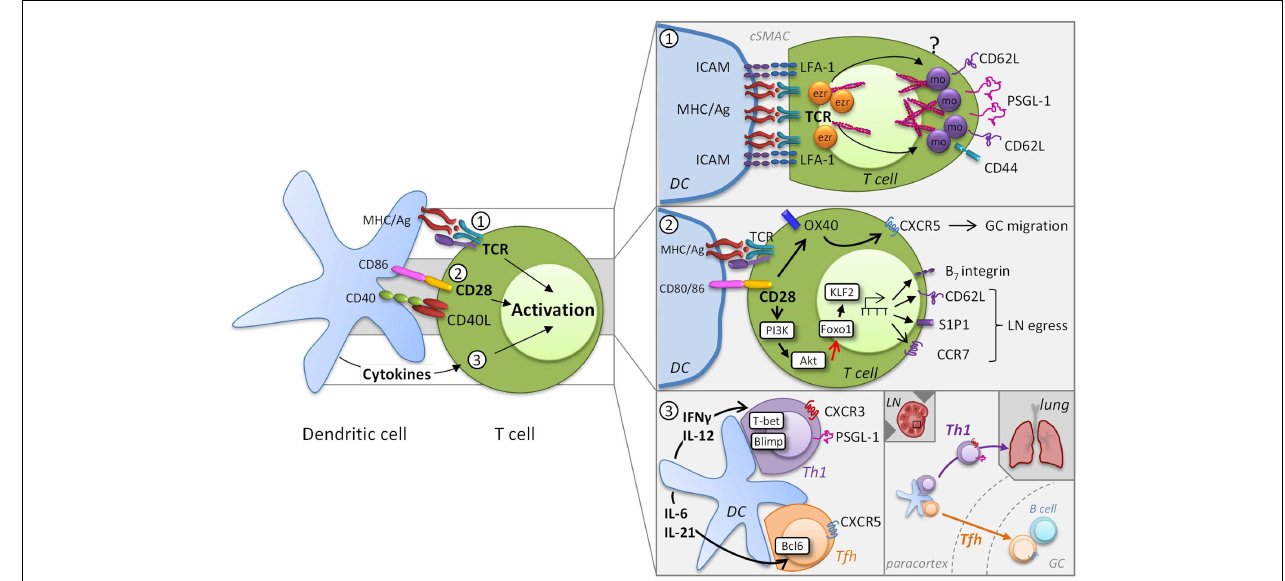
FIGURE 1 | Induction of migratory heterogeneity during priming . MR phenotype is impacted byTCR engagement, the level of co-stimulation, and the cytokine milieu ( left ). MR play a direct role in the formation of the immunological synapse, butTCR signaling subsequently impacts MR expression [panel 1, adapted from Ref. (8)]. Cytoskeletal rearrangements that involve the actin-binding ezrin (ezr), radixin, and moesin (mo) proteins are necessary forTCR signaling complex polarization.The integrin LFA-1 forms a ring surrounding the cSMAC that supports prolongedT cell-DC engagement, while other MR become excluded from the cSMAC.This process is possibly due to differential polarization of ezrin and moesin. Co-stimulatory signaling through molecules also contributes to the migratory heterogeneity ofT cells (panel 2). For example, CD28 controls migration through upregulation of OX40, which is instrumental for